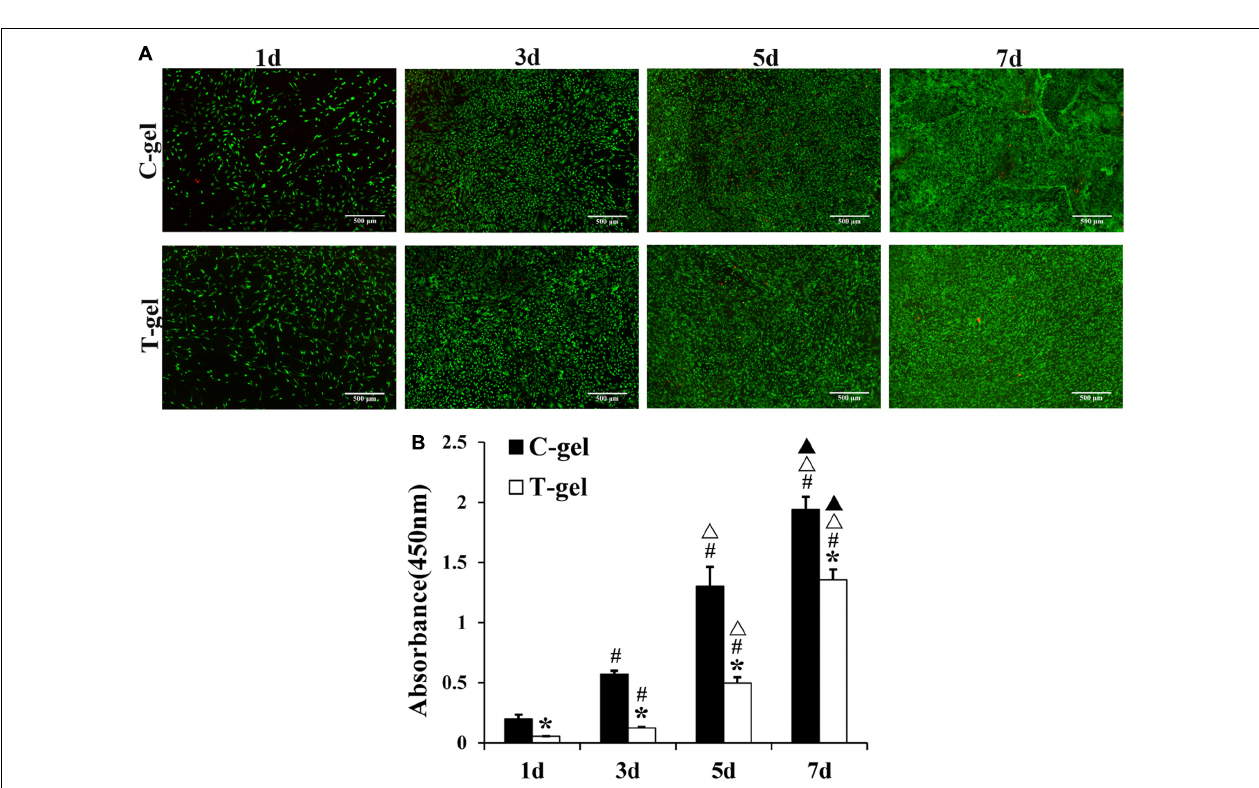
FIGURE 7 | Masson’s Trichrome staining of the C-gel and T-gel at 3, 7, 14, and 28 days post subcutaneous implantation. Scale bar = 200 µ m.